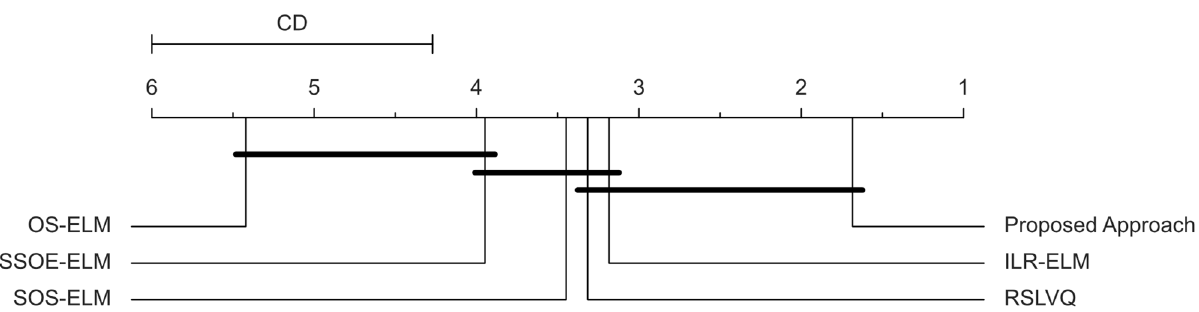
Figure 6. Critical distance (CD) diagram for the Friedman–Nemenyi post hoc test for comparison of this approach against other approaches.